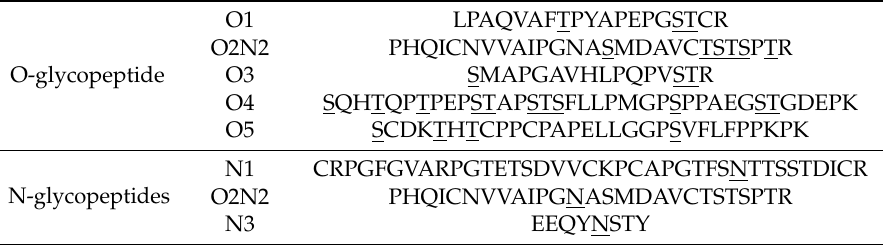
Table 2. Confirmed N/O-glycan sites of the tryptic